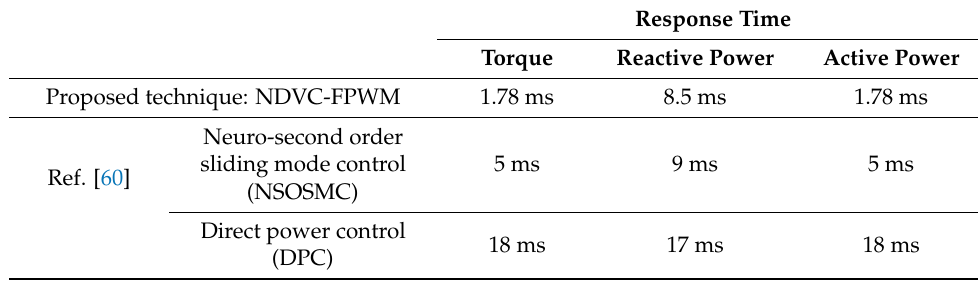
Table 3. Comparison between the proposed method and some methods in terms of response